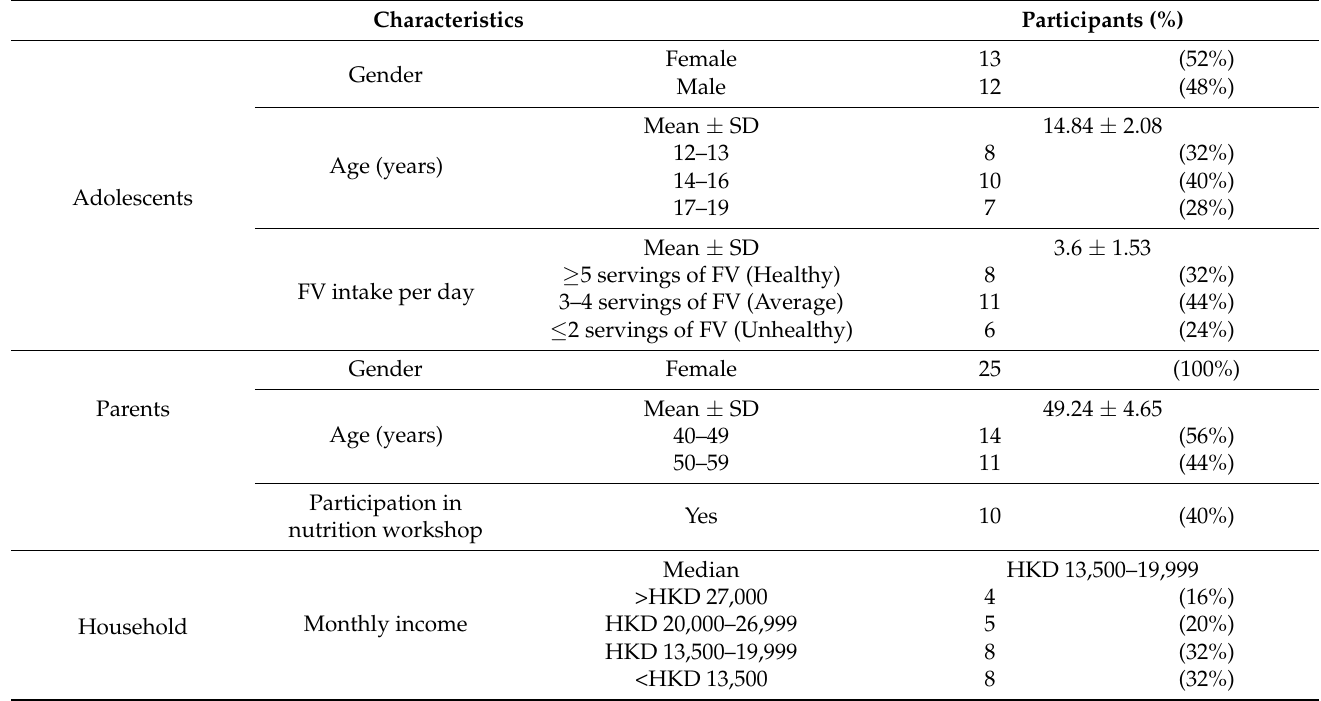
Table 1. Distribution of subject